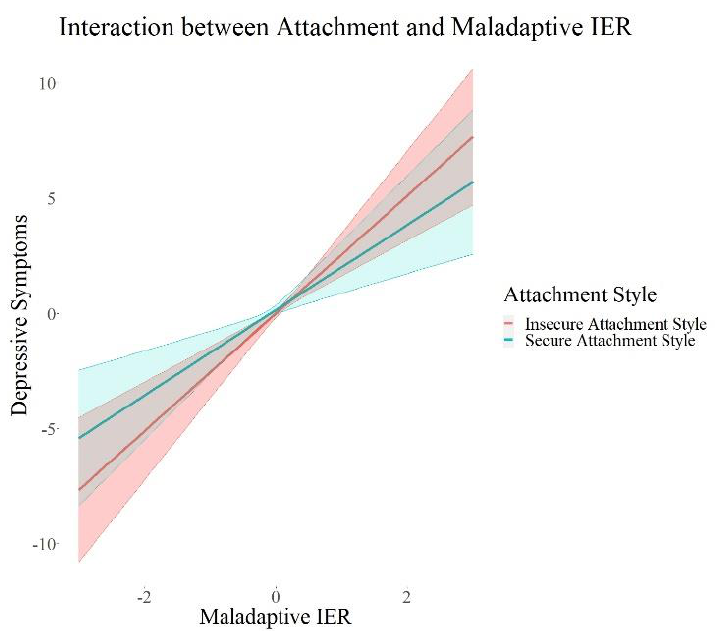
Figure 5. Interaction Effects between Attachment and Maladaptive IER on Depressive Symptoms. Note . The shades behind the thicker lines represent the 95% confidence interval. All variables were standardized, and the scales on the graph represent standard deviations (i.e., 2 = 2 units of standard deviation).